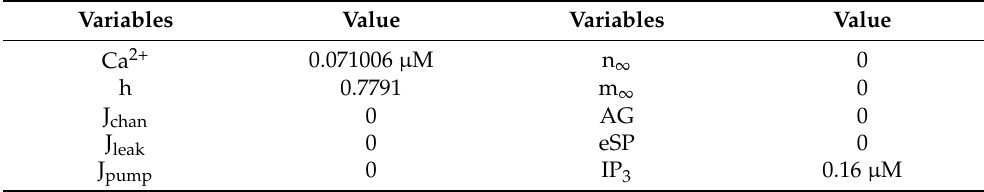
Table A3. Initial variables for the astrocyte